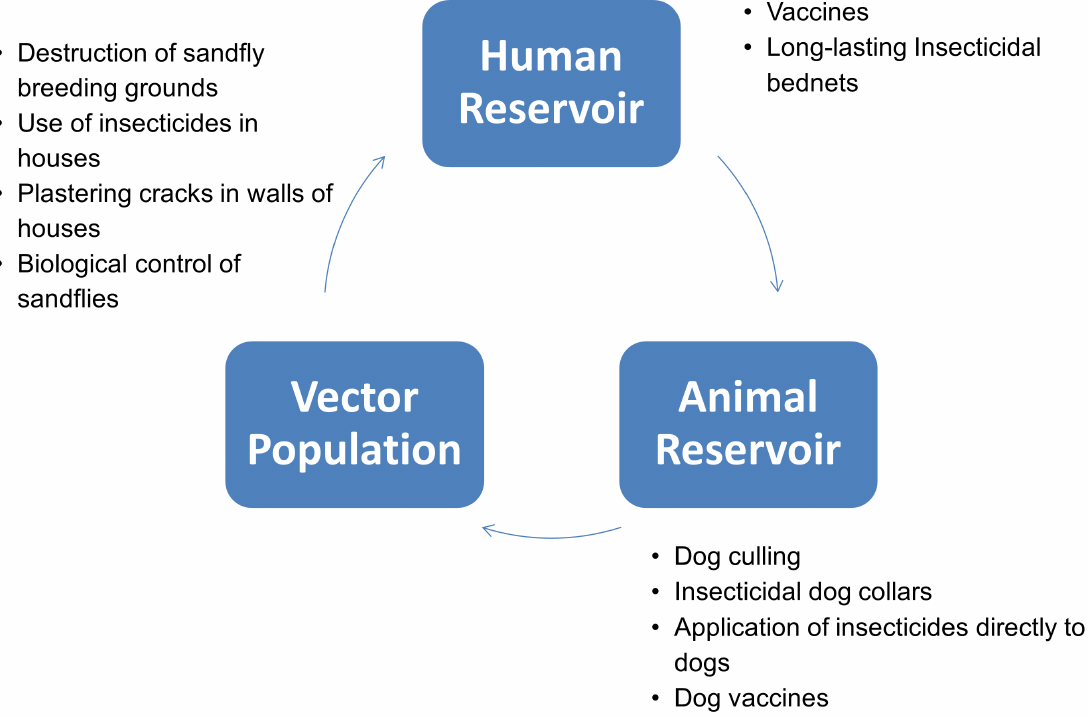
Figure 1. Range of preventative interventions. Potential areas of intervention include; targeting the vector population, the animal reservoir population, or attempting to either prevent humans being bitten, being infected, or from developing clinical symptoms.